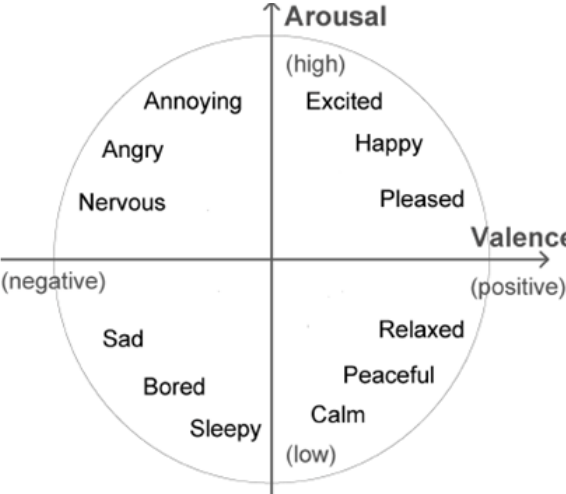
Figure 2. Thayer’s arousal–valence emotional plane.